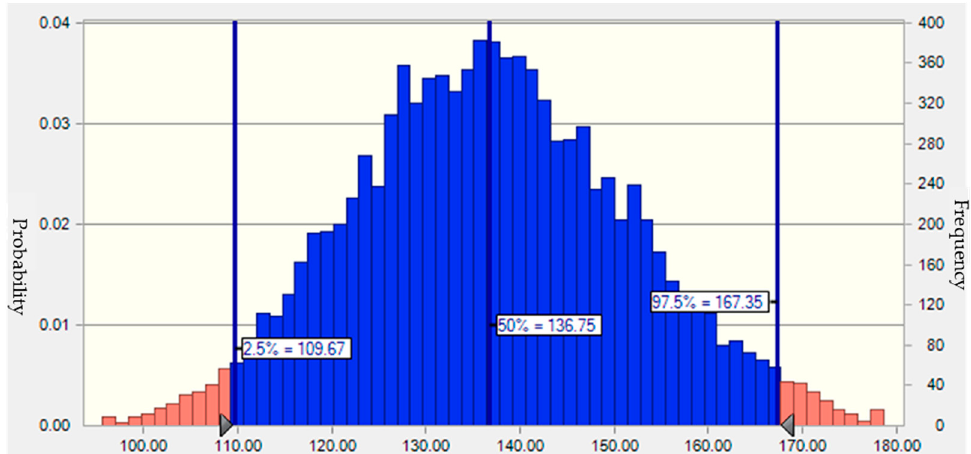
Figure 11. Probability distribution for the residential solar LCOE. Table 4. Residential solar LCOE statistics.